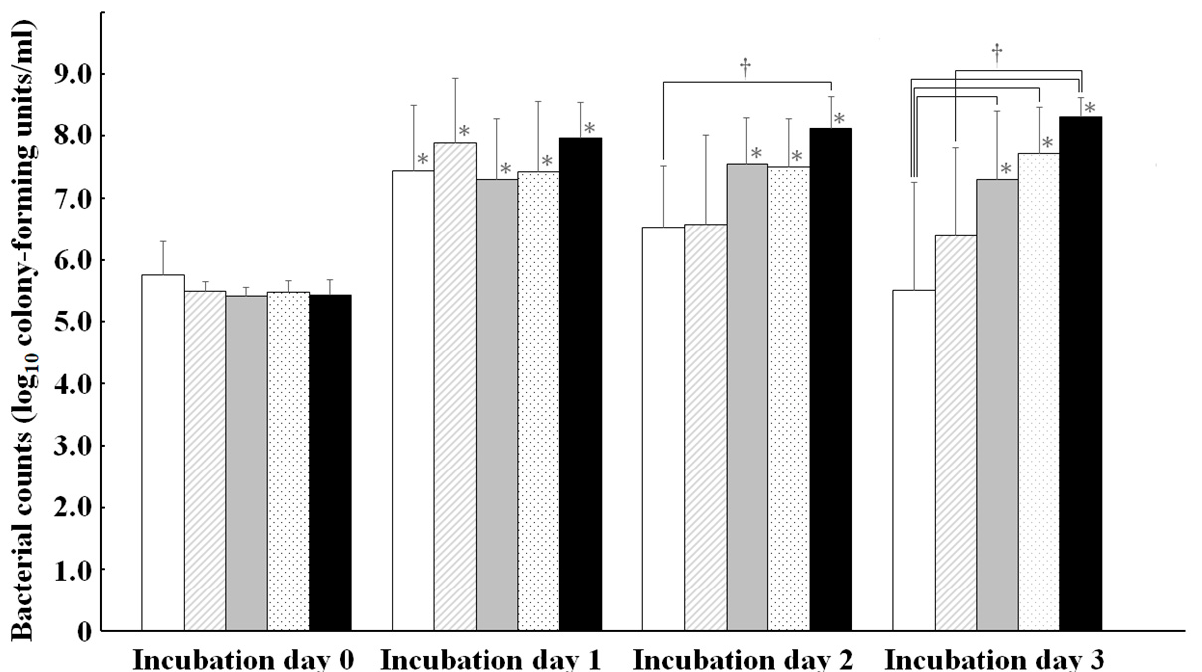
Figure 2. Correlations among Klebsiella pneumoniae isolates grouped by KP0 (white), KP1 (diagonal), KP2 (gray), KP3 (dotted), and KP4 (black) for the growths in iron-deficient medium. * Asterisks denote significant ( p < 0.05) differences for each value of KP groups on incubation day 0. † Dagger symbols denote significant ( p < 0.05) differences between KP groups, connected by a line.